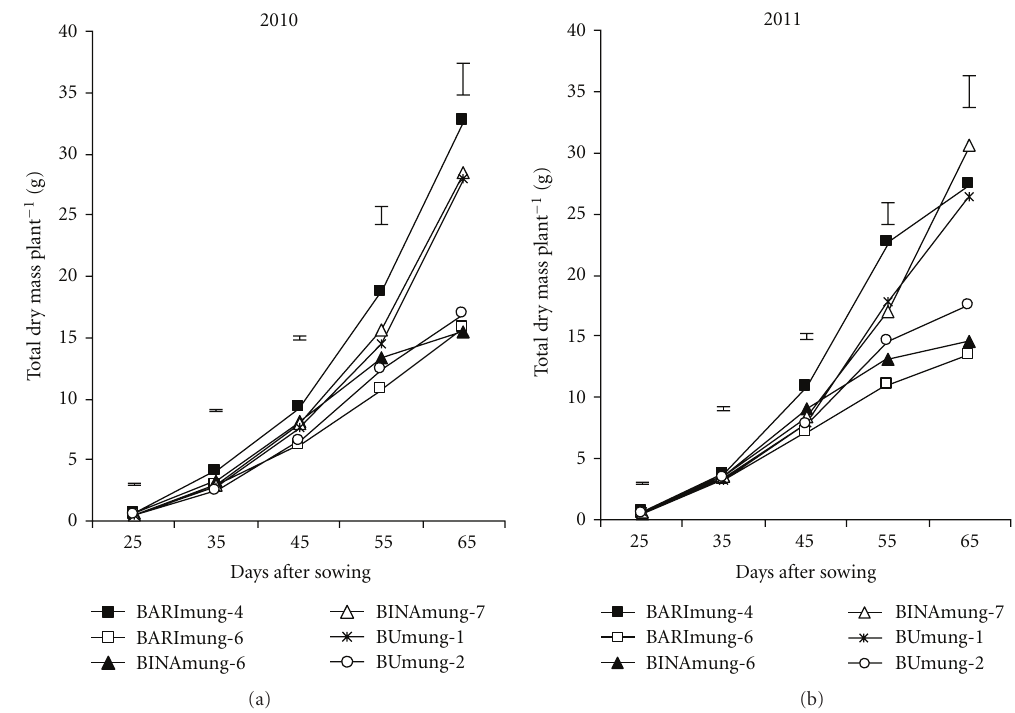
Figure 2: Changes in total dry mass at di ff erent ages in six mungbean varieties. Vertical bars represent LSD